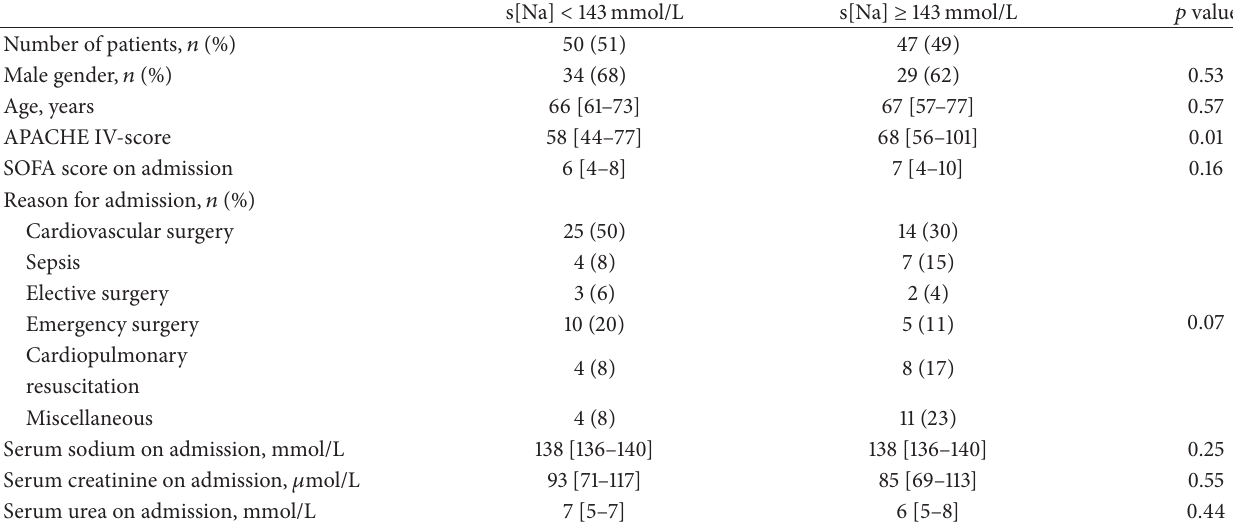
Table 1: Baseline characteristics balance study. sNa: serum sodium concentration.